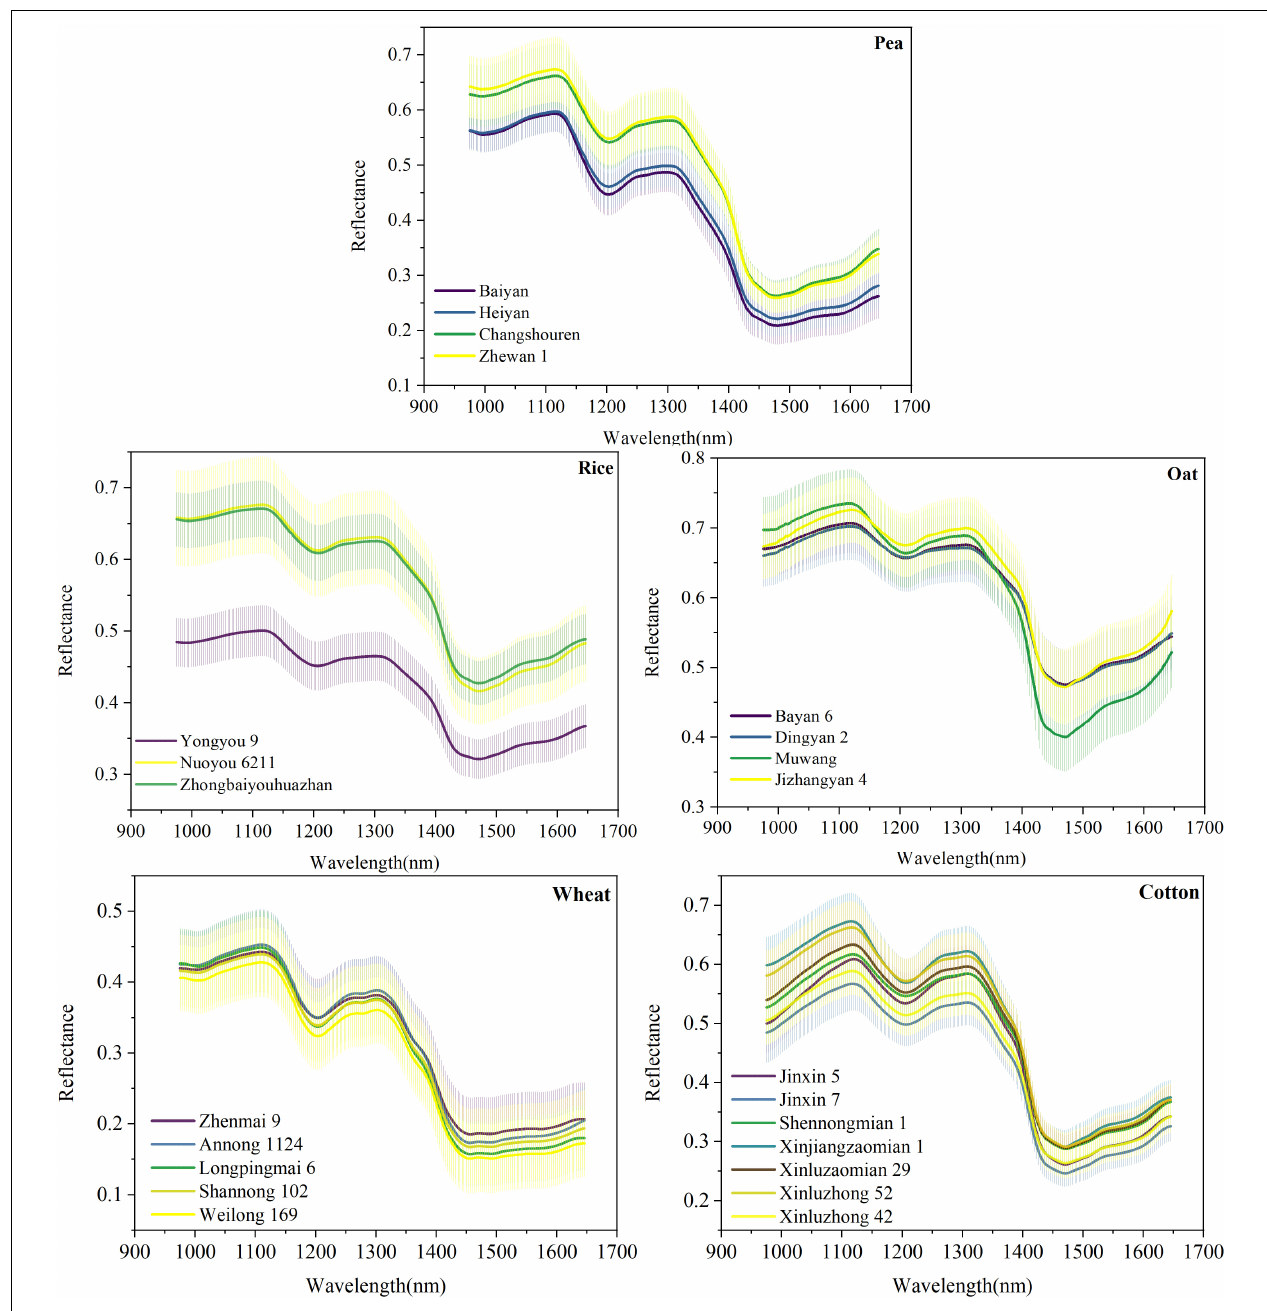
FIGURE 4 | The average spectra with the standard deviation of five crop